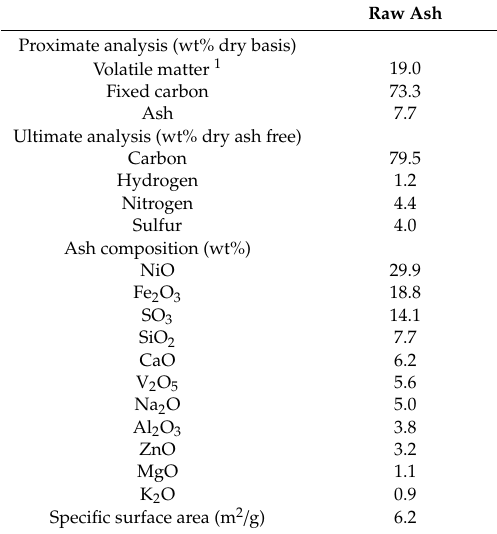
Table 1. Analyses of raw